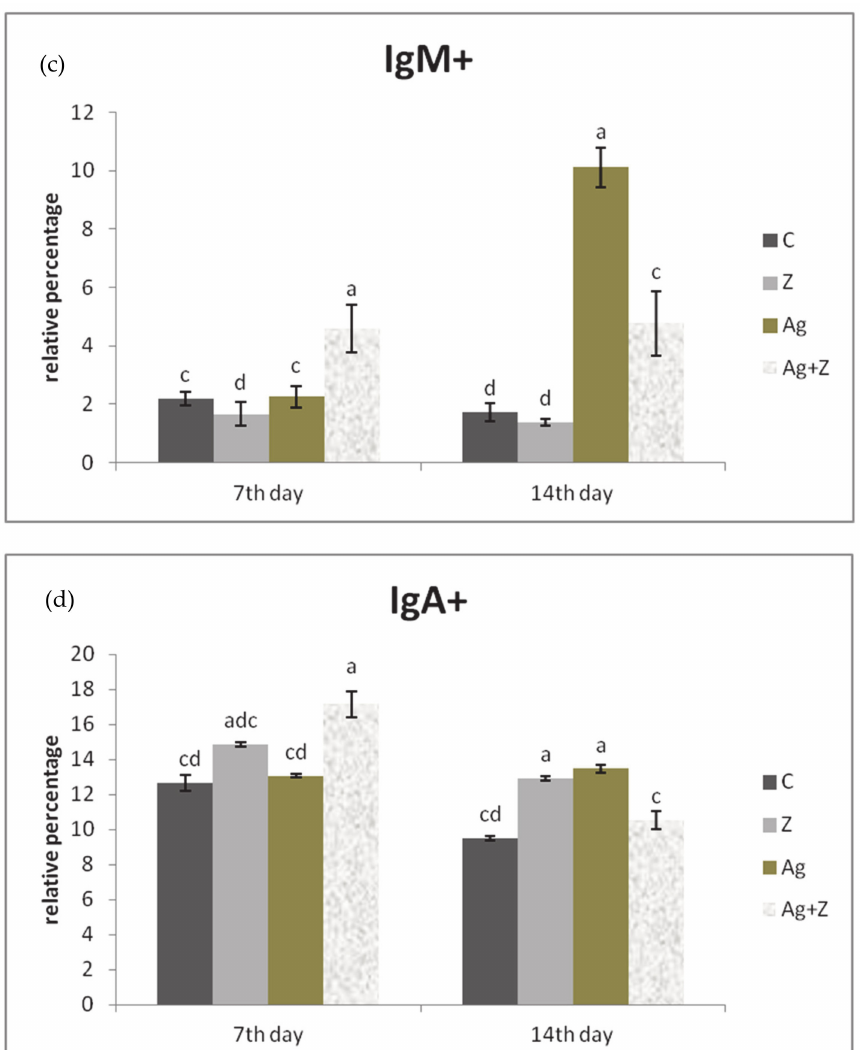
Figure 6. Effect of the administration of inorganic ZnSO 4 and infection by A. galli on the relative percentage of ( a ) CD4+, ( b ) CD8+ ( c ) IgM+, and ( d ) IgA+ LPL in the jejunum. Means with different superscripts are significantly different. ab p < 0.05; ac p < 0.01; ad p <